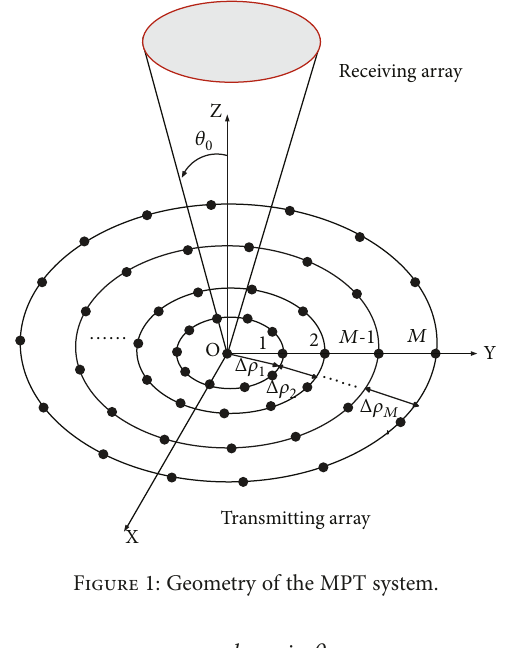
Figure 1: Geometry of the MPT